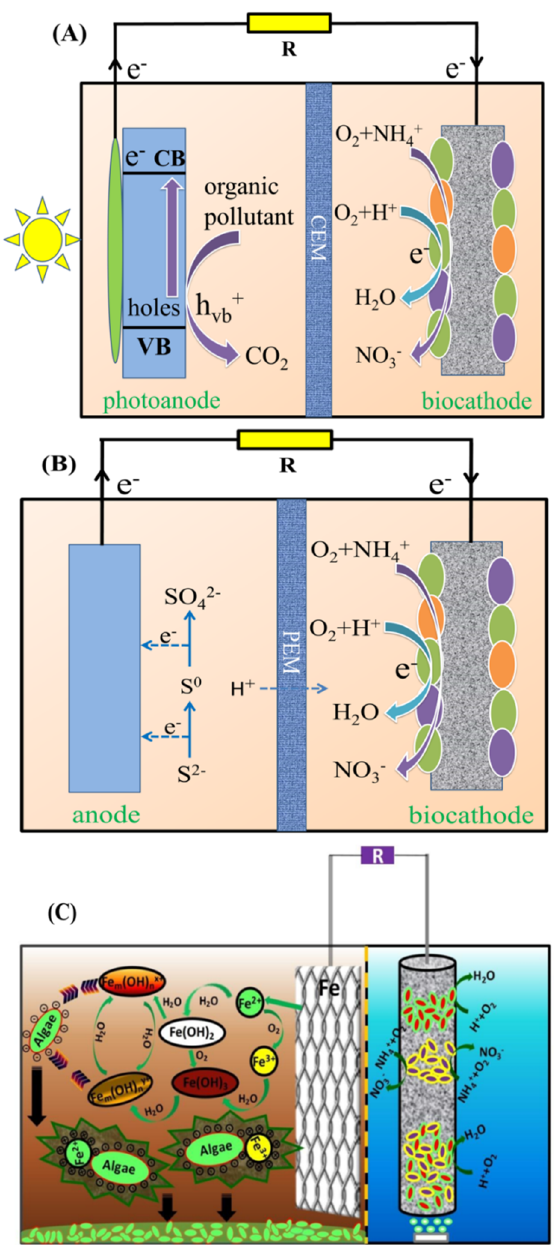
Figure 4. ( A ) Biocathode coupled photoelectrochemical cell, modified from [63]; ( B ) Schematic diagram of the MFC., modified from [40]; ( C ) Schematic diagrams of biocathode-coupled electrocoagulation cell (bio-ECC) and the reactions in the anode and cathode [64]. Reproduced with copyright, Elsevier.